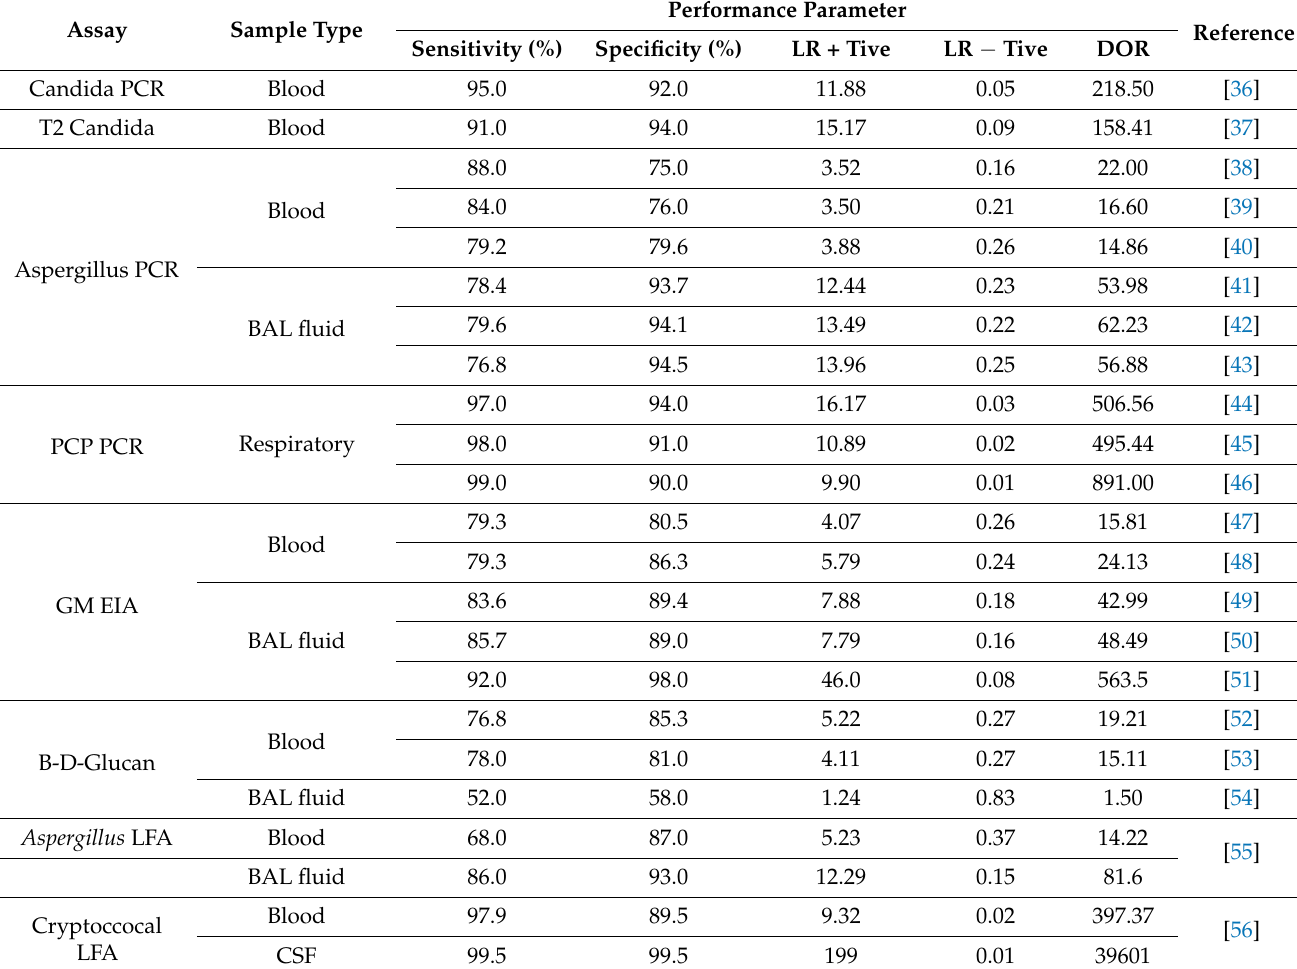
Table 1. The performance of molecular diagnostics and biomarker assays for the diagnosis of